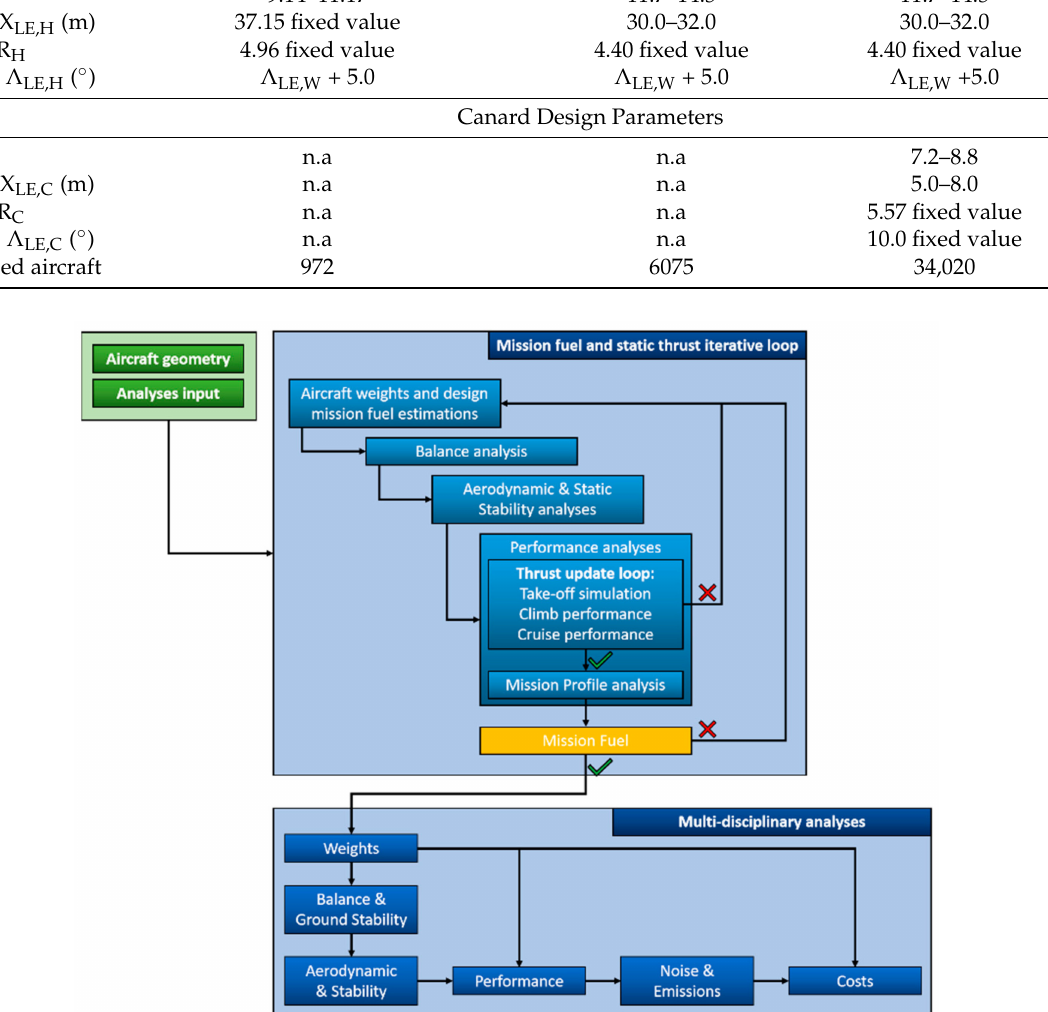
Figure 6. JPAD MDA workflow including thrust update inner